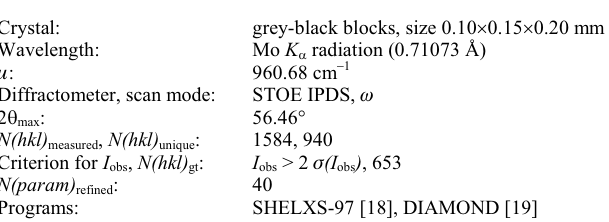
Table 1. Data collection and